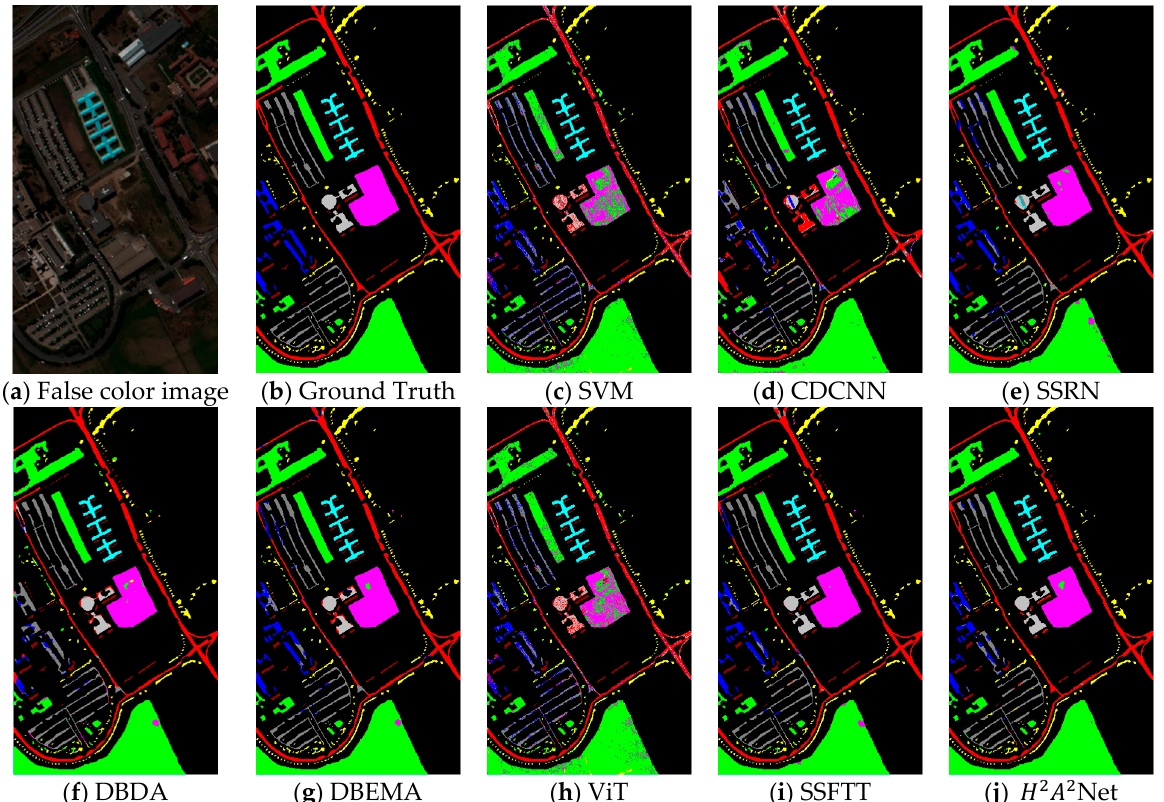
Figure 8. Classification maps achieved via different methods for the UP dataset. ( a ) False color image, ( b ) Ground Truth, ( c ) SVM (84.17%), ( d ) CDCNN (87.32%), ( e ) SSRN (92.81%), ( f ) DBDA (93.63%), ( g ) DBEMA (96.05%), ( h ) ViT (84.02%), ( i ) SSFTT (96.63%), ( j ) 𝐻 (cid:2870) 𝐴 (cid:2870) Net (97.71%).